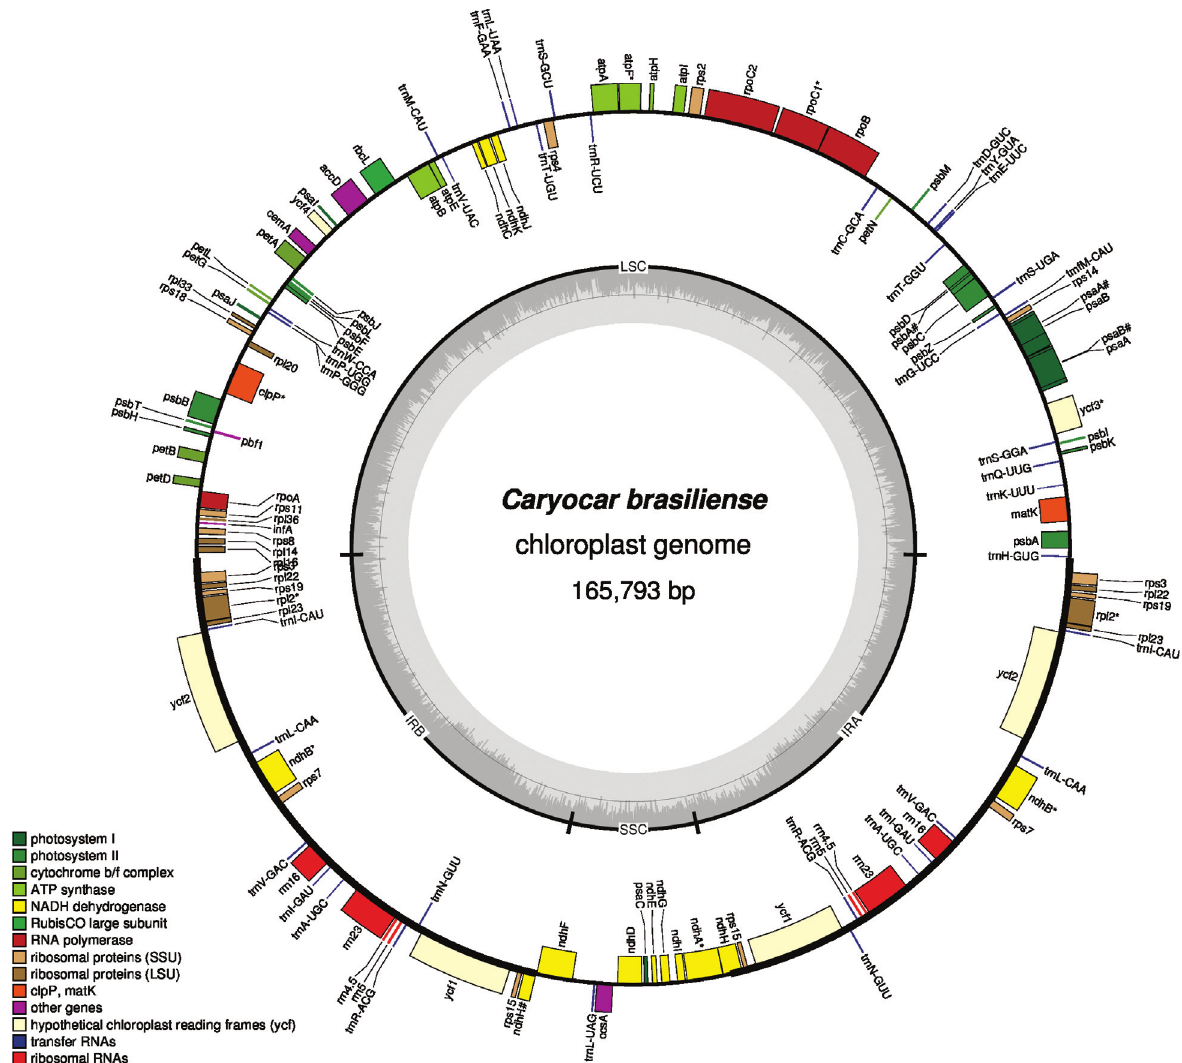
Figure 1 - Chloroplast genome map of Caryocar brasiliense . The genes drawn outside and inside of the circle are transcribed in clockwise and counter- clockwise directions, respectively. Genes were colored based on their functional groups. The inner circle shows the quadripartite structure of the chloroplast:smallsinglecopy(SSC),largesinglecopy(LSC)andapairofinvertedrepeats(IRaandIRb).ThegrayringmarkstheGCcontentwiththein- ner circle marking a 50% threshold. Genes that have introns were marked with “*” and pseudogenes were marked with